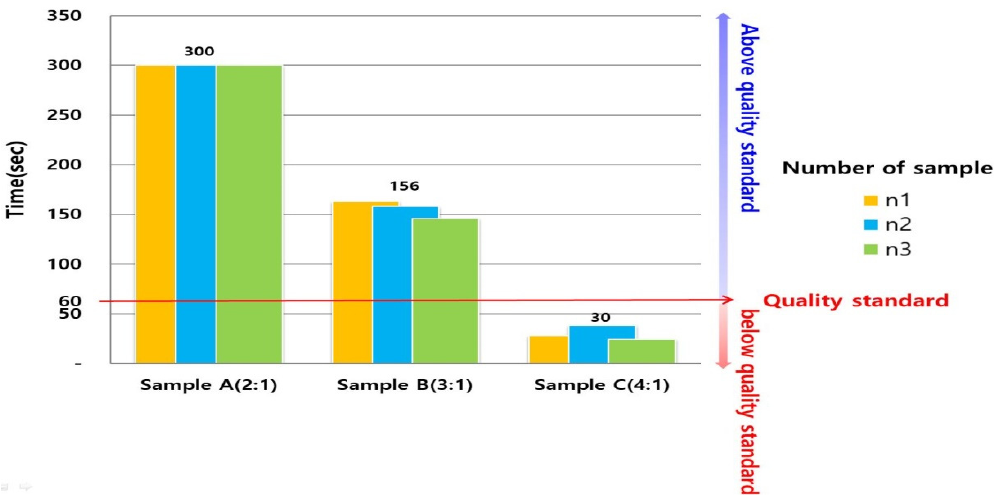
Figure 10. Wet surface adhesion by sample of W-SPRG.